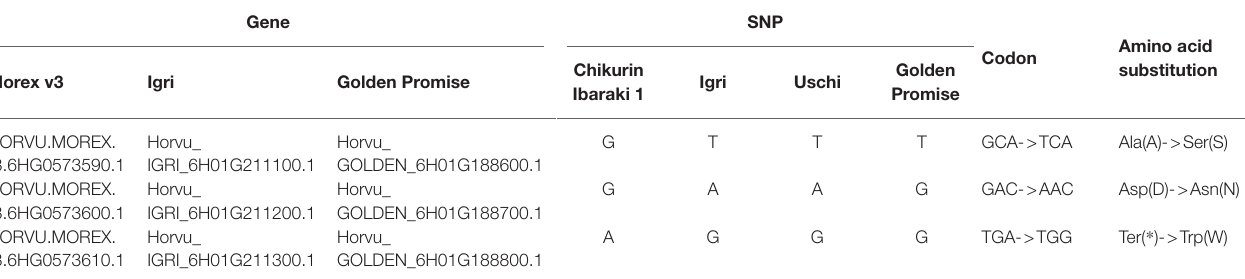
TABLE 2 | Functional SNPs between resistant (Chikurin Ibaraki 1) and susceptible (Igri, Uschi and Golden Promise) lines originated from three candidate genes. Gene SNP